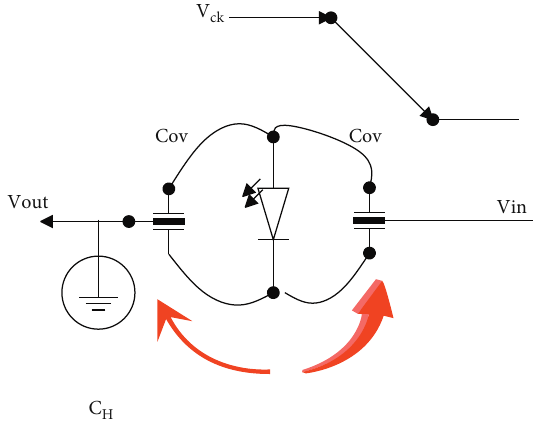
Figure 7: Schematic diagram of charge injection and clock feedthrough effects.